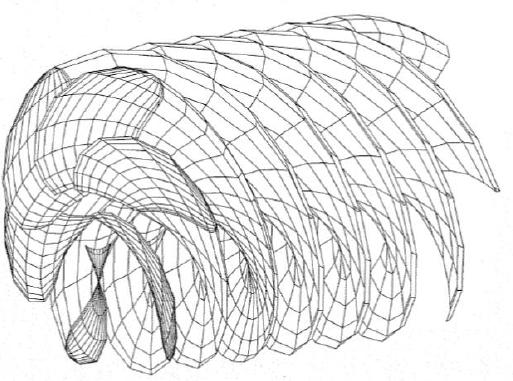
Figure 1. Vortex structure in the propeller wake in QCM for a typical propeller in a homogeneous inflow.